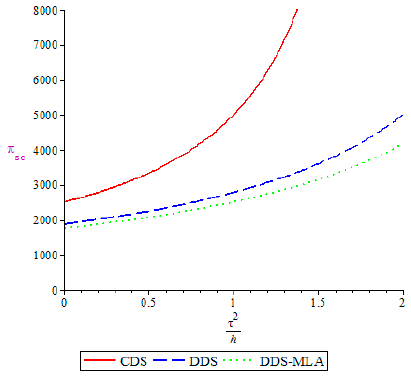
Figure 8. The impact of green efficiency coefficient on profit of green supply chain. Mathematics 2019 , 7 , x FOR PEER REVIEW